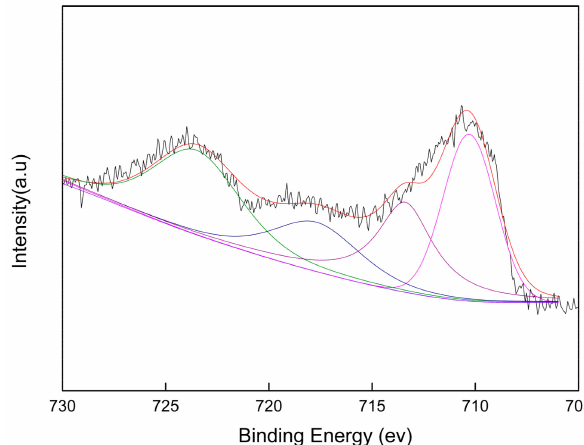
Figure 7. XPS spectrum of the Fe 2p orbital on the surface of the modified rare earth